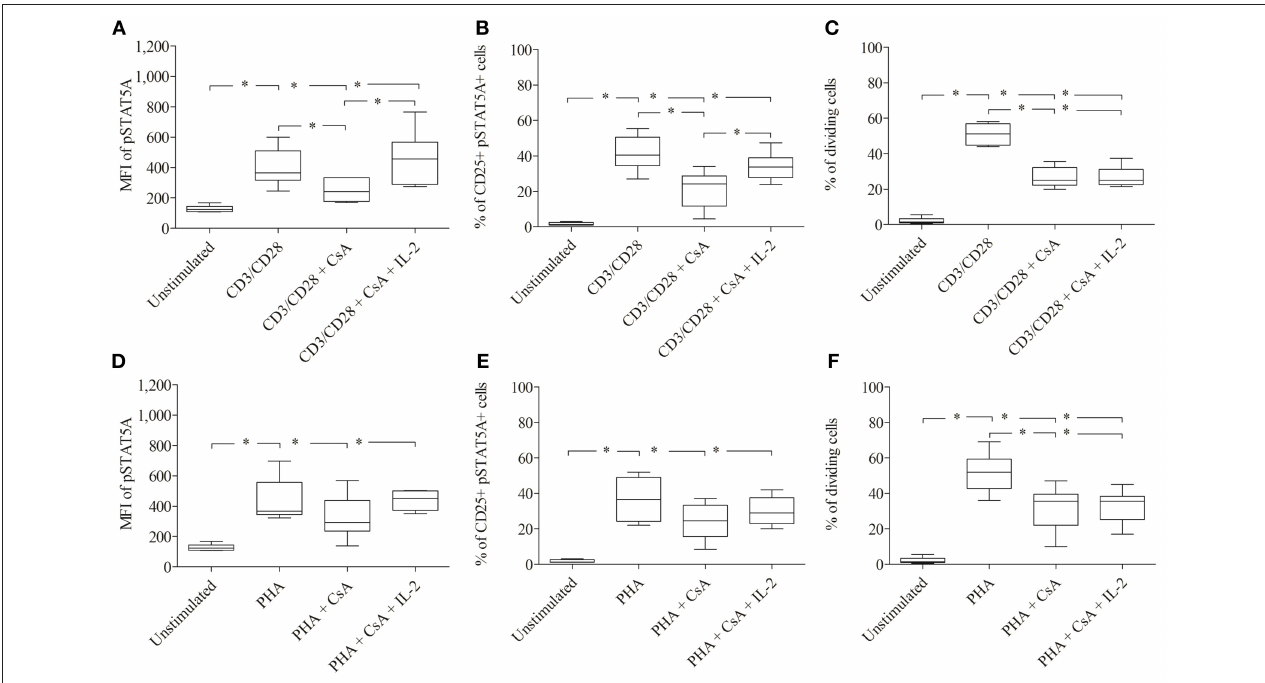
FIGURE 6 | Inhibition of IL-2 transcription by Cyclosporine (CsA) correlates with an inhibition of JAK3/STAT5 mediated signal transduction and proliferation. CD3/CD28 (A–C) or PHA (D–F) —stimulated T cells were either treated with CsA (500nM) or with CsA (500nM) + IL-2 (100ng/ml). After 24h the MFI of pSTAT5A (A,D) , the percentage of CD25 + pSTAT5A + cells (B,E) and after 72h proliferation were determined (C,F) . The bold line inside each box plot shows the median, upper and lower lines indicate the maximum and minimum values, respectively (Curves were evaluated by the non-parametric Friedman test). * p < 0.05 (Wilcoxon’s test); n = 6 independent experiments; MFI, median fluorescence intensity.